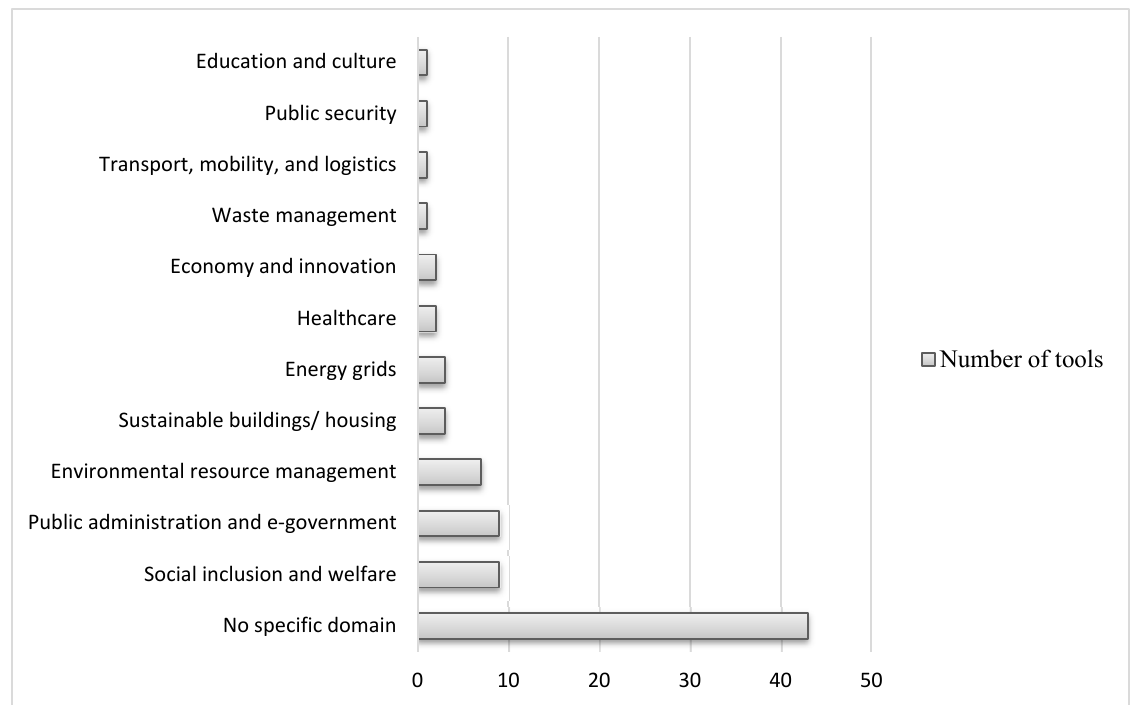
Figure 3. Number of tools found for different smart city domains.